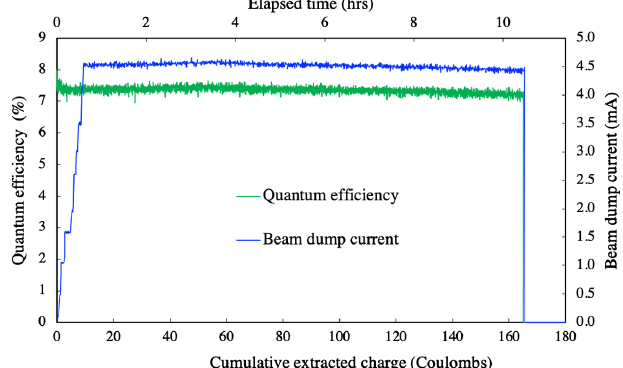
FIG. 12. Photocathode QE measured over 10 hours with the photogun biased at − 300 kV and delivering 4.5 mA average current. The 1 = e QE charge lifetime was ∼ 6600 C. The anode was biased at þ 1000 VDC, and the beam line ion precipitator at − 200 VDC. The drive laser was operating at 374 MHz with 22 ps pulses rms producing 12 pC bunch charge. The laser spot size at the photocathode was 0.04 cm rms positioned off center 0.25 cm, on Cs K Sb photocathode with 0.5 cm diameter active x y